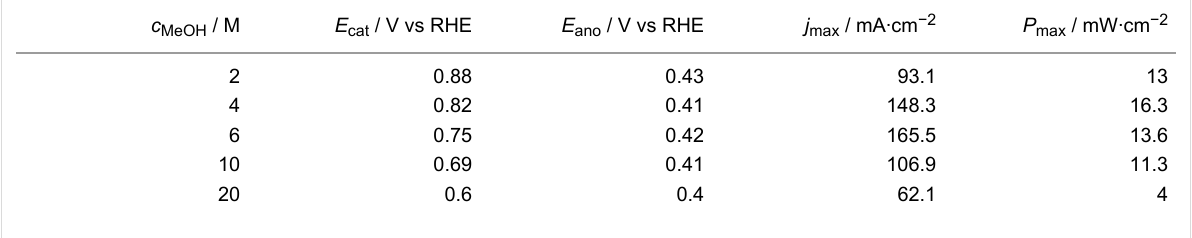
Table 1: Cathode ( E cat ) and anode ( E ano ) potential, maximum current ( j max ) and power ( P max ) density of the µDMFC with different concentrations of CH 3 OH.